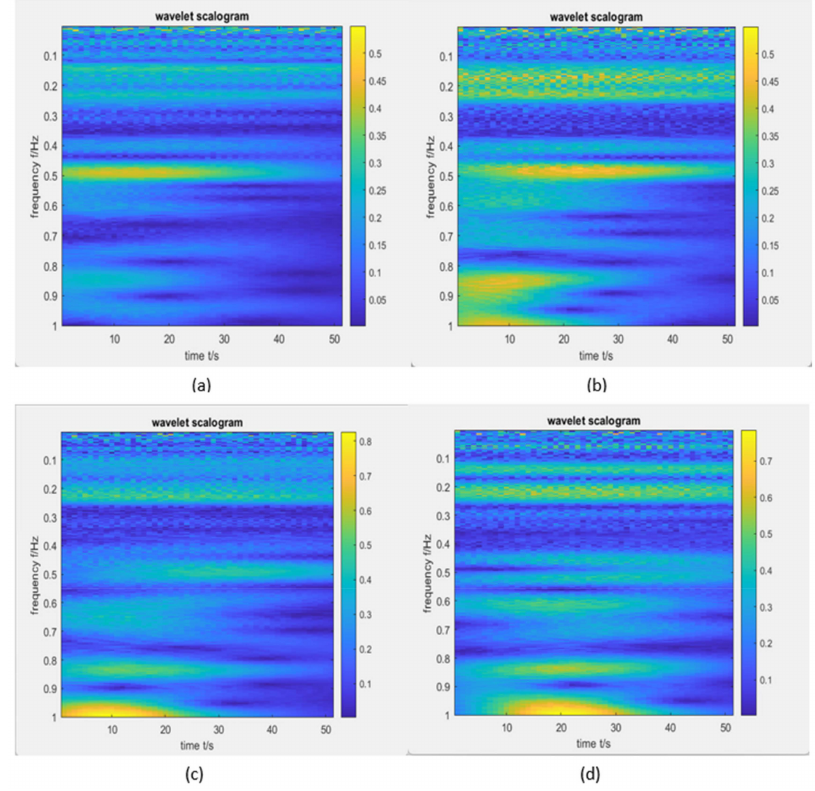
Figure 6. Four of the 31 CWT scalograms in one semi-time segment: ( a ) fuzzy pulses in frequency ranges 0.4–0.5 Hz and others, ( b ) fuzzy pulses in frequency ranges 0.4–0.5 Hz, 0.8–0.9 Hz, 0.9–1.0 Hz and others, ( c ) fuzzy pulses in frequency ranges 0.9–1.0 Hz and others, ( d ) fuzzy pulses in frequency ranges 0.8–0.9 Hz, 0.9–1.0 Hz and